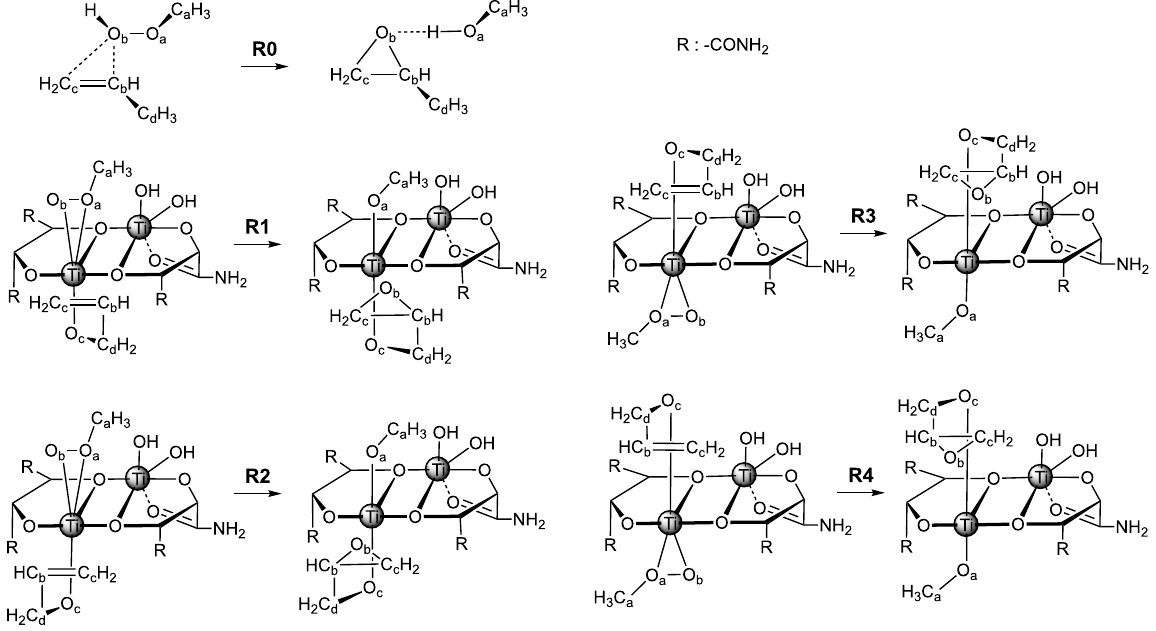
Figure 2. Schemes of the chemical reactions investigated in this study. R0 : non-catalyzed reaction, R1 – R4 : catalyzed reactions with different orientation of the reactants coordinated at one of the Ti